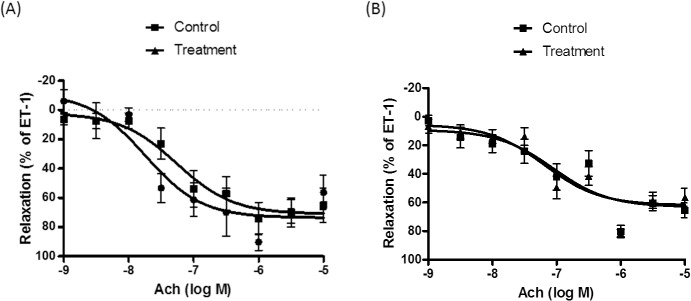
Effect of long-term treatment of abacavir on acetylcholine-induced relaxation of rat basilar arteries.Rats were treated with (A) 16 mg/kg/day of abacavir and (B) 160 mg/kg/day of abacavir for 4 weeks. Rats not treated with abacavir served as controls. Acetylcholine (Ach)-induced relaxation of basilar arteries was then measured. Changes in tension were expressed as a percentage decrease in response to contraction caused by endothelin-1 (ET-1; 1–10 nM). Values are means ± S.E.M. of eight sets of experiments and statistical comparisons were made using ANOVA.